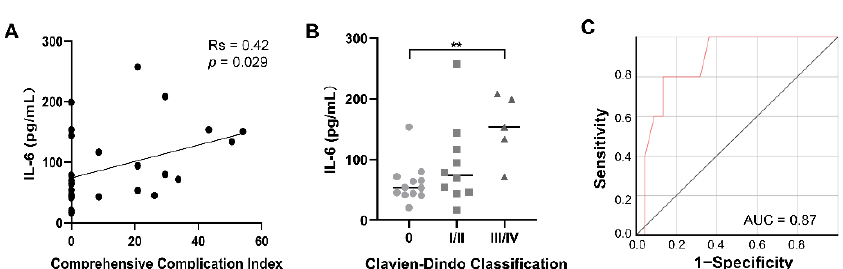
Figure A1. Serum cytokines levels correlated with prognosis of patients treated with IRE: ( A ) IL-6 is positively correlated with comprehensive complication index; ( B ) IL-6 is related to the severity of the complications according to the Clavien–Dindo Classification; and ( C ) the predictive value of IL-6 was assessed using receiver operating curve. The area under the receiver operating curve was 0.87. **, p < 0.01.